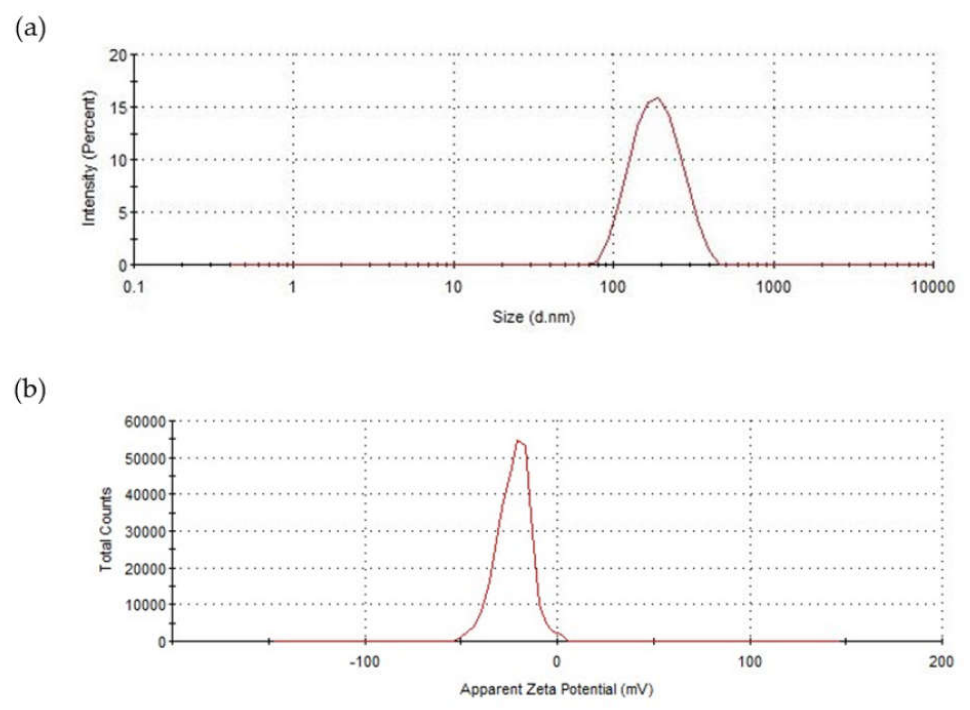
Figure 4. ( a ) Representative size distribution profile based on intensity and ( b ) zeta potential of polymersomes (measured in PBS at 25 ◦ blank polymersomes (measured in PBS at 25 °C).